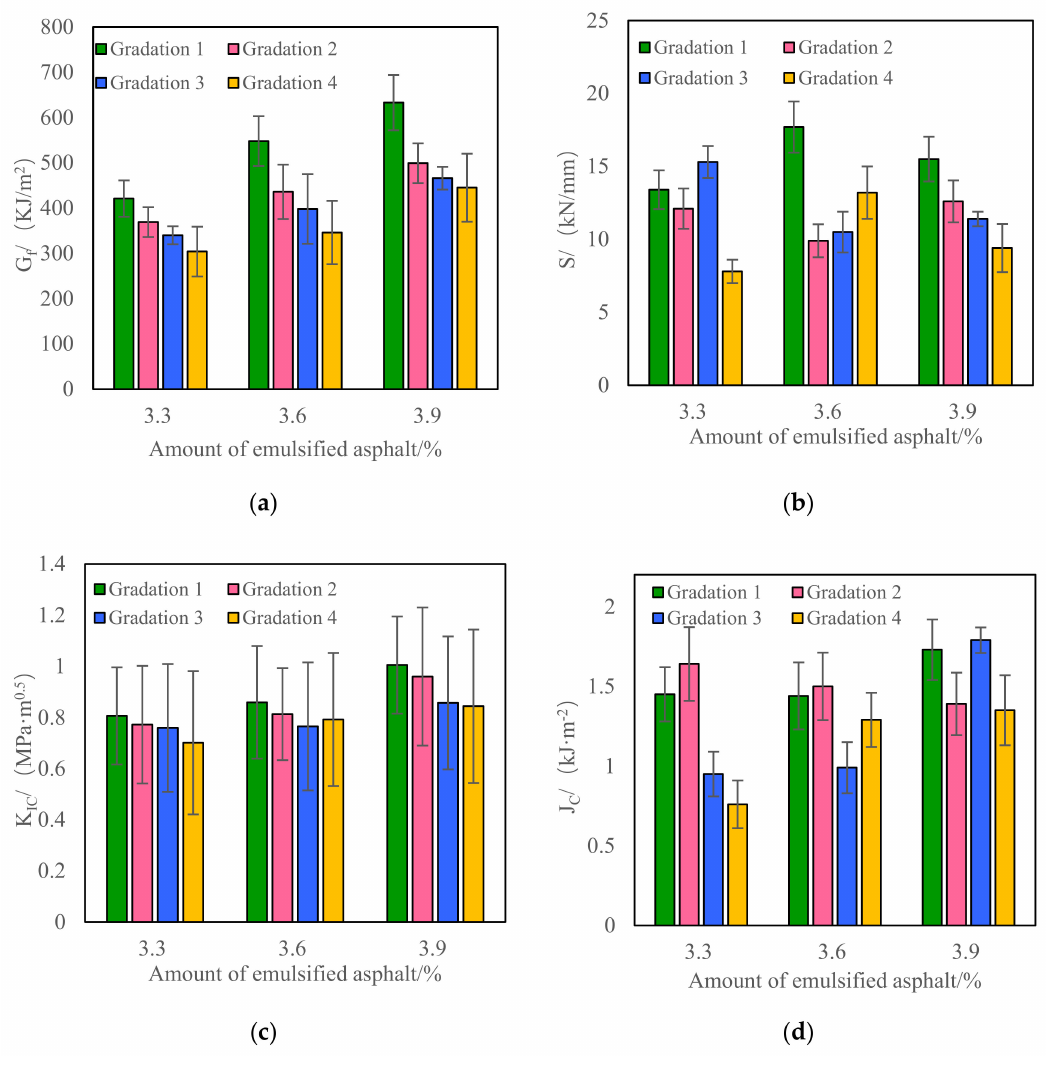
Figure 3. Low-temperature performance test results of CRM under different grades and emulsified asphalt dosage (SCB test). ( a ) Gf; ( b ) S; ( c ) KIC; ( d )